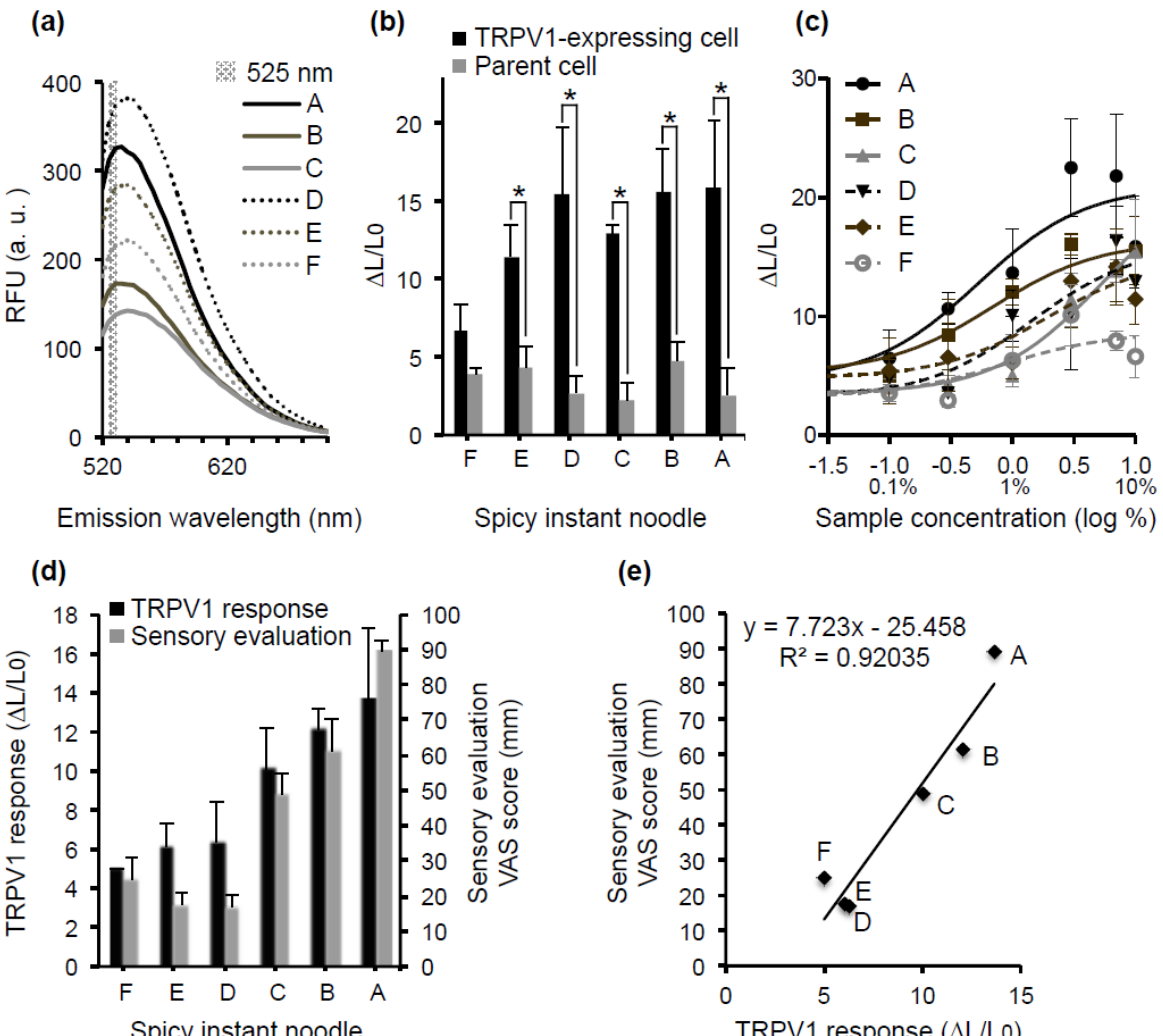
Figure 5. hTRPV1 activity and pungency intensity of spicy instant noodles. ( a ) Six types of spicy instant noodles (designated A–F) were tested. Fluorescence spectra of six kinds of the noodle broths when they were irradiated with fluorescent light (490 nm). The gray range shows the emission wavelength (525 nm) that is used for the fluorescence-based hTRPV1 assay. ( b ) Ca 2+ responses elicited by 10% noodle broth on the hTRPV1-expressing cells (black) and parent cells not expressing hTRPV1 (gray). Data are presented as the average ( n = 3) ± SE (error bars); * p < 0.05 (unpaired t -test). ( c ) Concentration–response curves for hTRPV1 activity induced by noodle broths using the luminescence assay. Data are presented as the average ( n = 3) ± SE (error bars). ( d ) Correlation between hTRPV1 activity in the luminescence assay (black) and pungency intensity in the sensory test (gray) for 1% and 10% noodle broth, respectively. Data are presented as the average (hTRPV1 assay, n = 3; sensory evaluation, n = 12) ± SE (error bars). ( e ) Correlation analysis of hTRPV1 activity and the pungency intensity of six noodle broths.